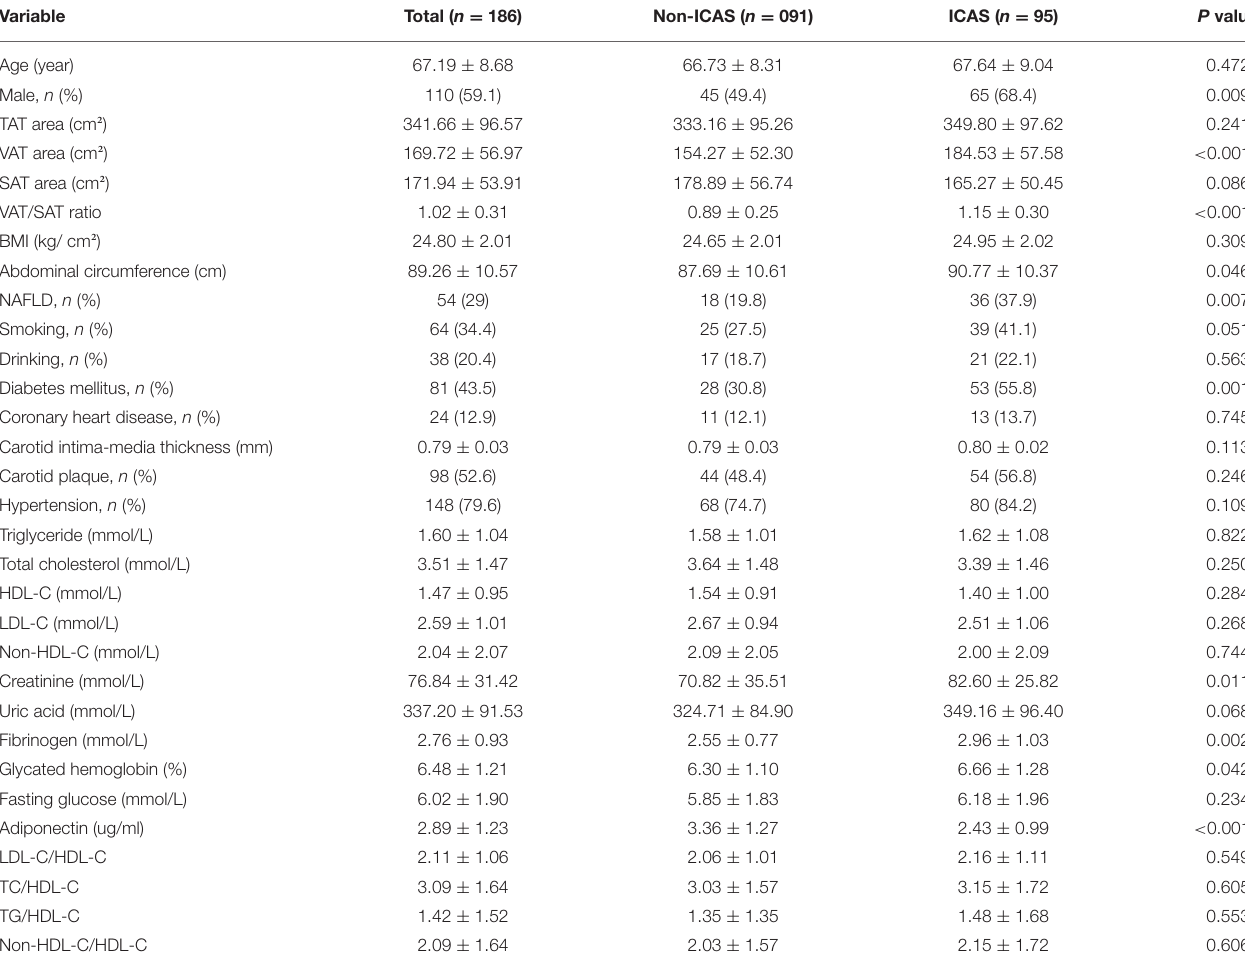
TABLE 1 | Clinical characteristics and abdominal adipose-relevant parameters of patients.